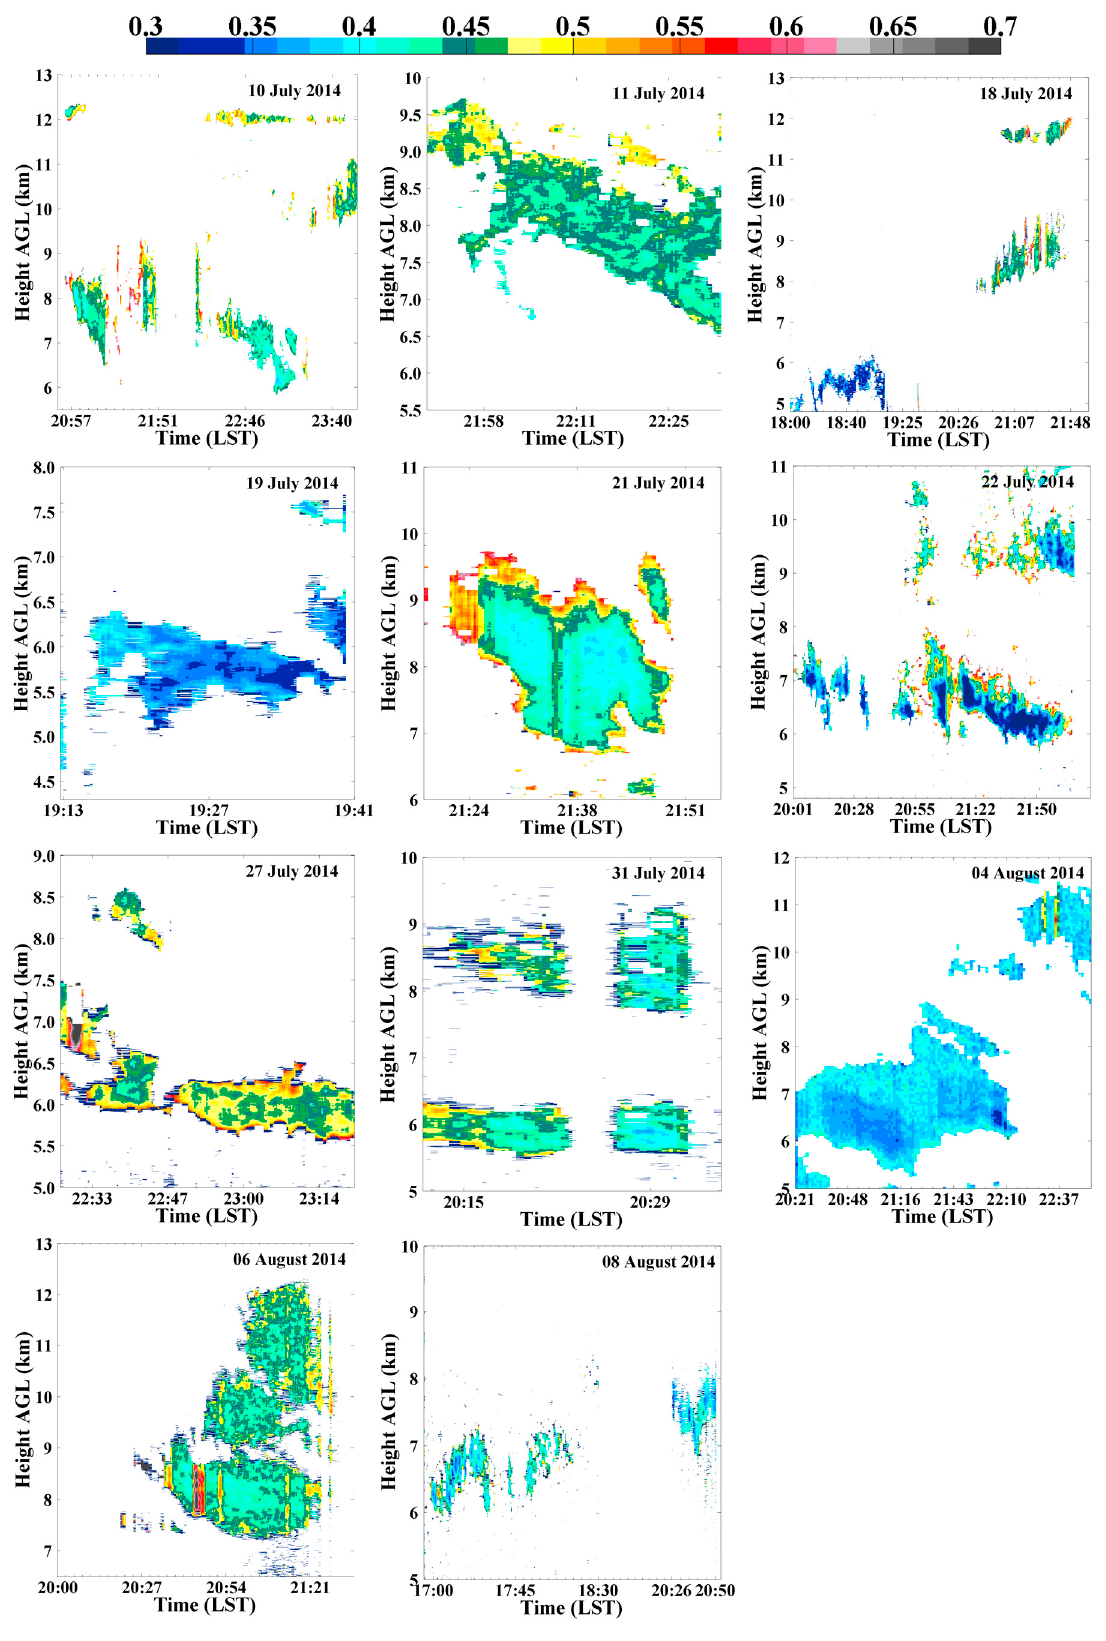
Figure 12. Particle depolarization ratio of cirrus measured during TIPEX III in Naqu.